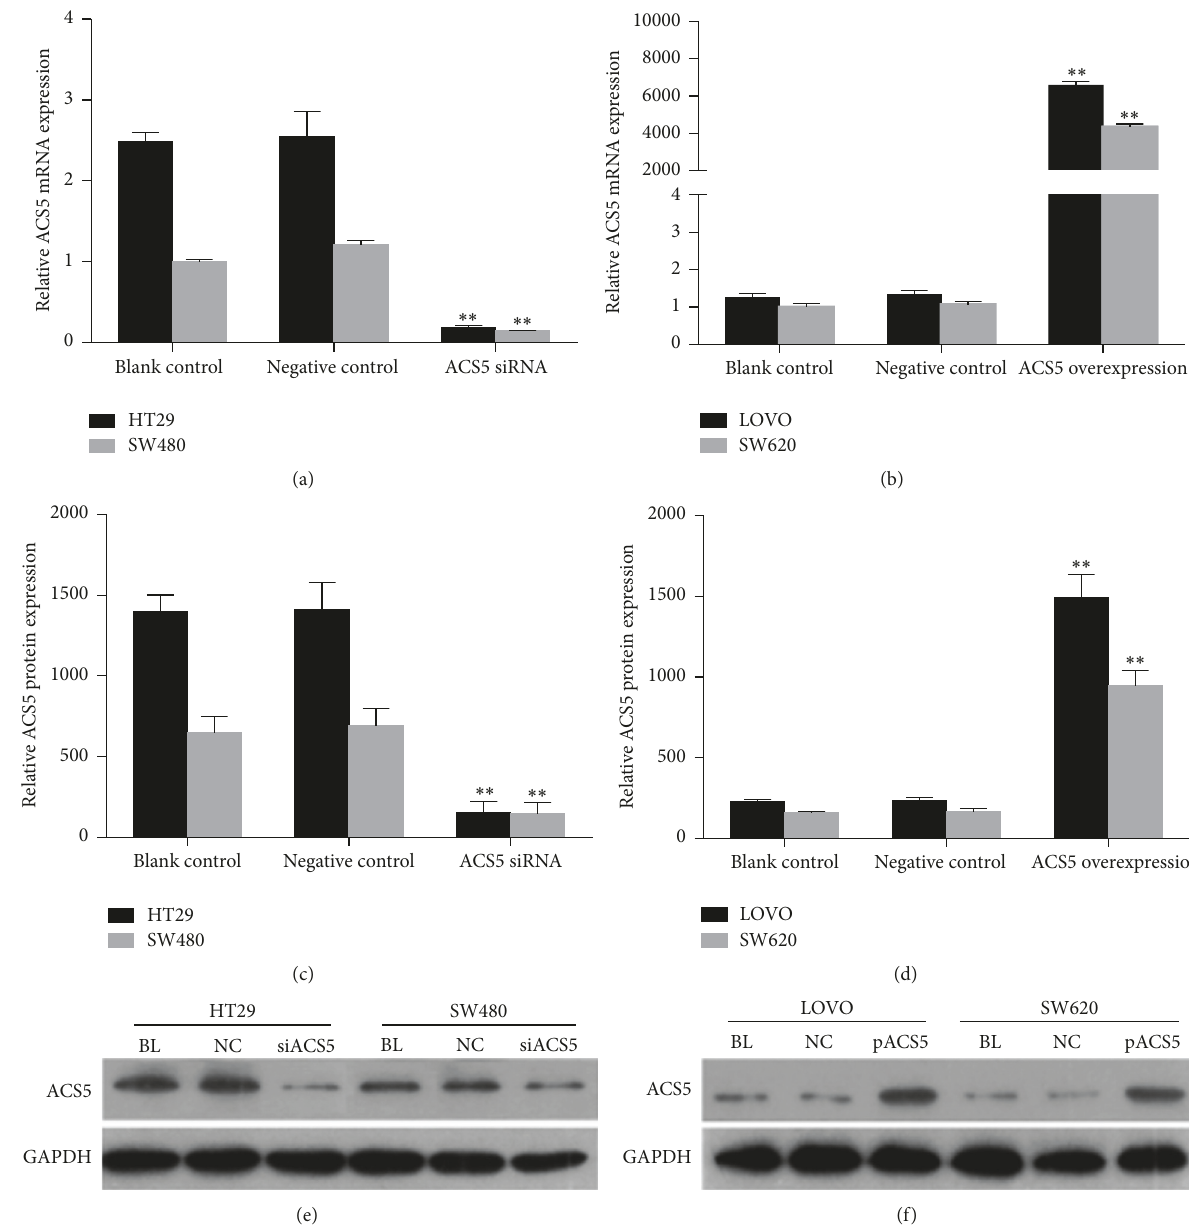
Figure 3: The level of ACS5 expression in CRC cells after transfection. ((a), (c)) ACS5 mRNA and protein levels were significantly lower in HT29 and SW480 cells with ACS5 knockdown than those in the negative control or blank control. ((b), (d)) ACS5 mRNA and protein levels were remarkably upregulated in LOVO and SW620 cells with ACS5 overexpression compared with the negative control or blank control. ((e), (f)) Representative western blot results of ACS5 protein expression. ∗∗ 𝑃 < 0.01 versus negative control or blank control group. BL, blank control; NC, negative control; siACS5, ACS5 siRNA; pACS5,